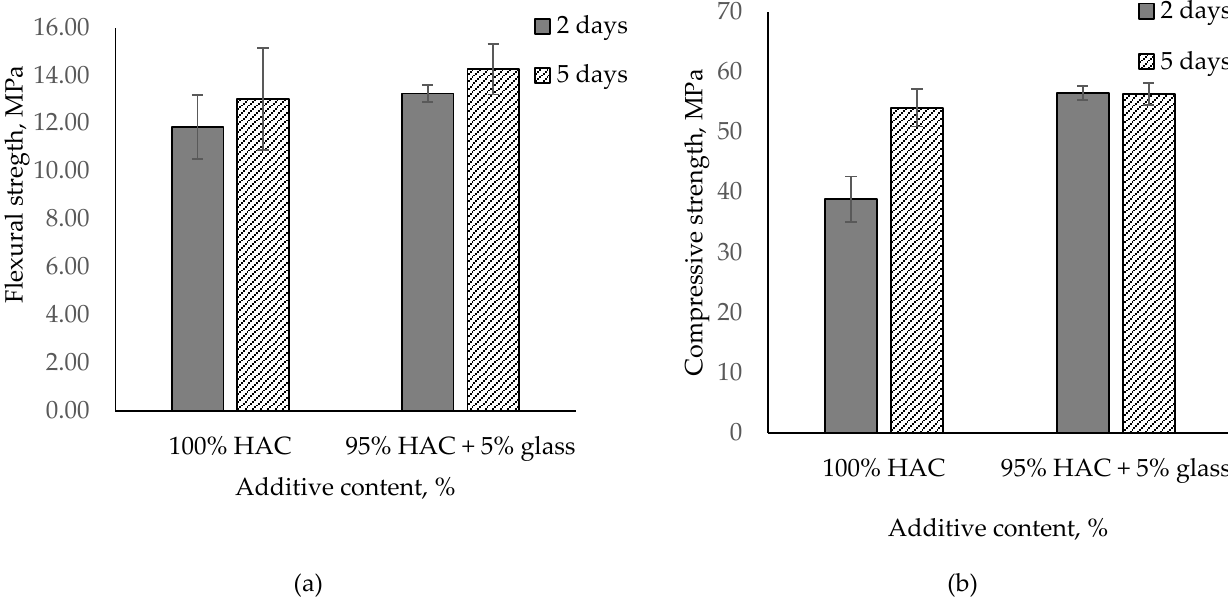
Figure 8. Flexural and compressive strength for the mortar paste of HAC with glass stored after 2 and 5 days. ( a ) Flexural stregth; ( b ) Compressive stregth.